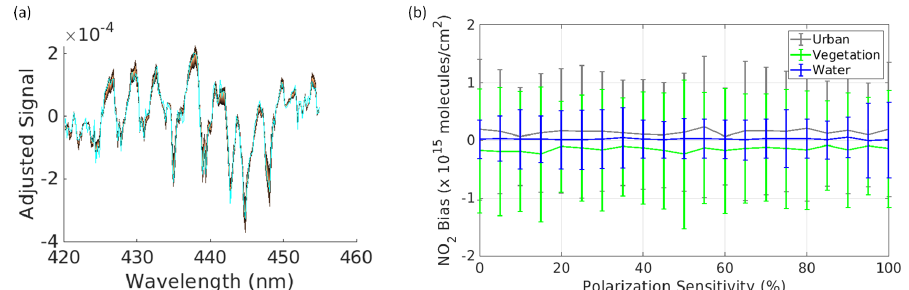
Figure 5. Clear-sky scene retrieval results: (a) an example of an adjusted ACX-simulated spectrum (cyan) with all spectra from the look-up table (LUT) with varying amounts of tropospheric NO 2 . (b) The average error (or bias) and standard deviation for 1000 total vertical NO 2 retrievals of the “high” amount (8 . 44 × 10 15 molec.cm − 2 ) for the three scene types (water, vegetation, and urban) at Norman, Oklahoma, assuming a vertical PS orientation.